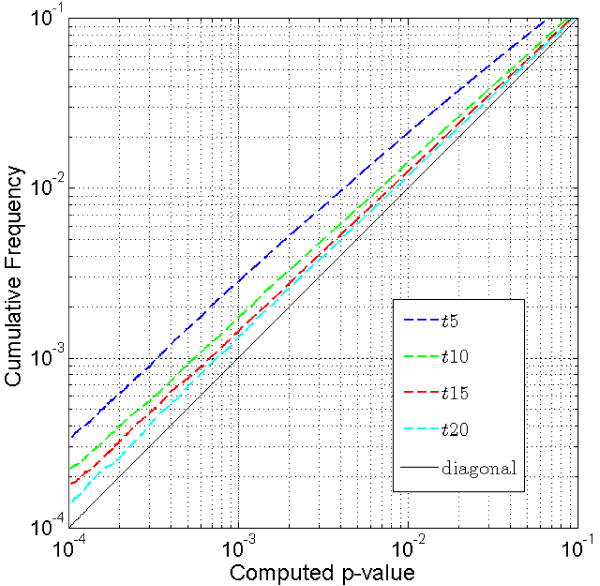
Cumulative distribution of p-values for t-test correction with sample size n = 5, 10, 15, 20. The convergence toward the diagonal as sample sizes increase is illustrated by the p-values in the interval, 0.0001 to 0.1, for the t-test correction where the empirical distributions were estimated from 1 million iterations.